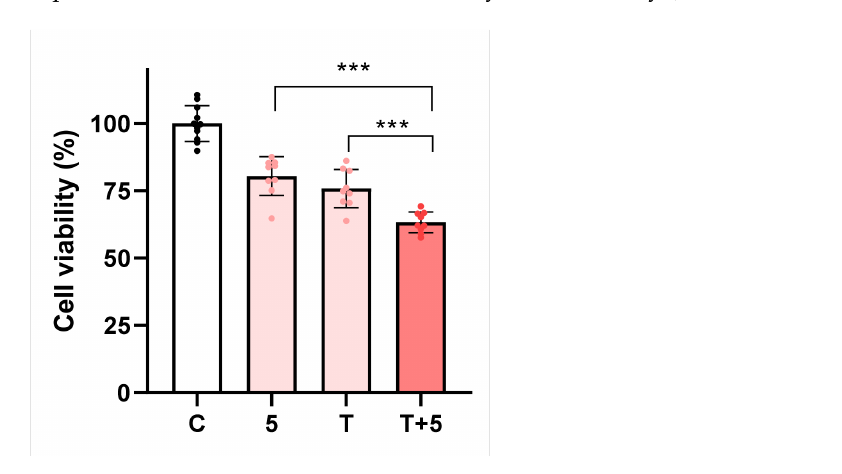
Figure 5. Viability of AGS cells exposed to molecule 5 at 100 µ M combined with topotecan at 2.5 µ M. Each dot represents a single determination. C: control; T: topotecan. *** p <